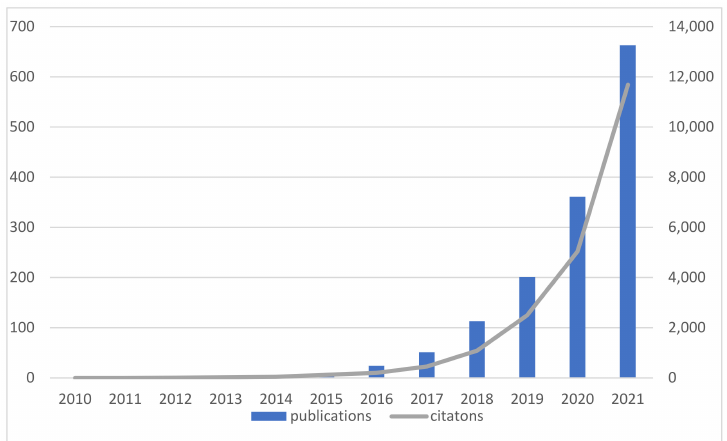
Figure 2. Annual distribution of the overall distribution trend of academic